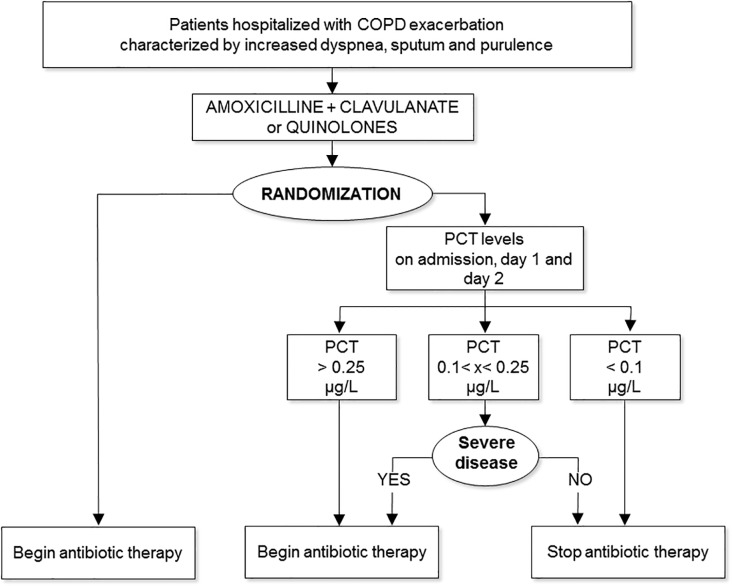
Trial protocol. Severe disease = respiratory failure or clinical instability.